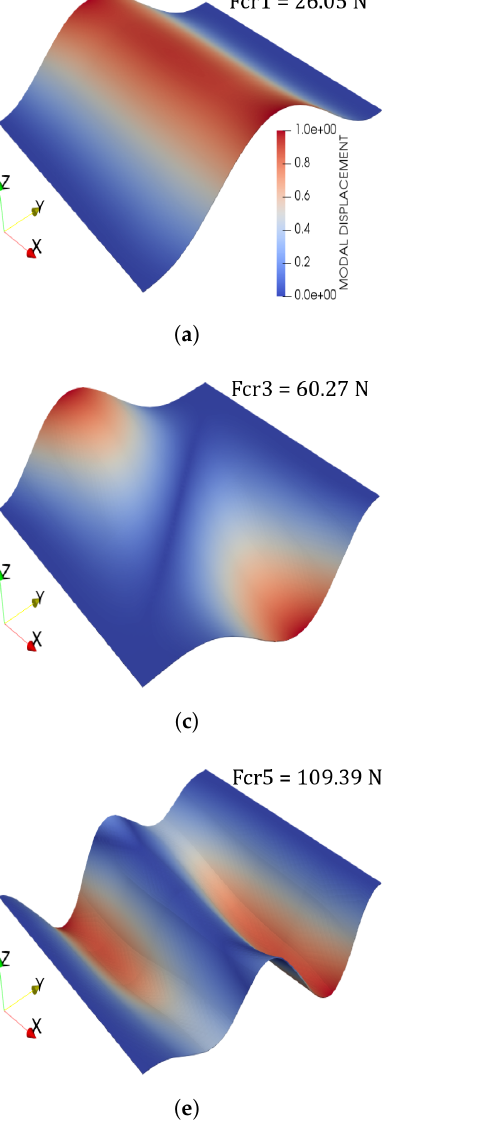
Figure 12. ( a ) First mode, ( b ) Second mode, ( c ) Third mode, ( d ) Fourth mode, ( e ) Fifth mode, ( f ) Sixth mode. Case 2 pristine buckling modes. A uniform fibre volume V f = 0.60 is considered and no fibre waviness. The colour bar in ( a ) applies for all figures in this panel. Table 7. Case 2 critical buckling loads mean value and standard deviation calculated by means of pure Monte Carlo and first- and second-order